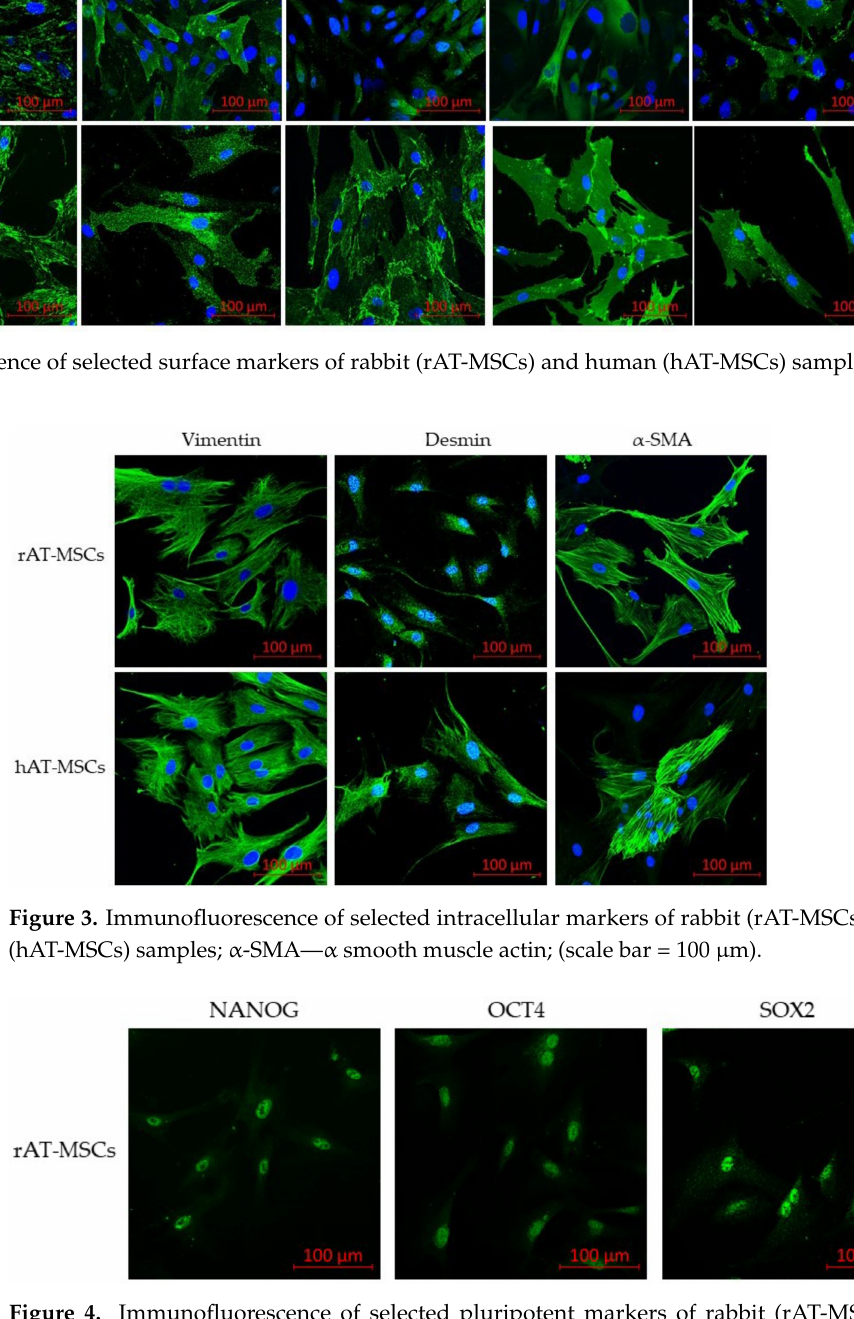
Figure 4. Immunofluorescence of selected pluripotent markers of rabbit (rAT-MSCs) samples; SOX2—sex determining region Y—box 2; OCT4—octamer-binding transcription factor 4; (scale bar = 100 µ